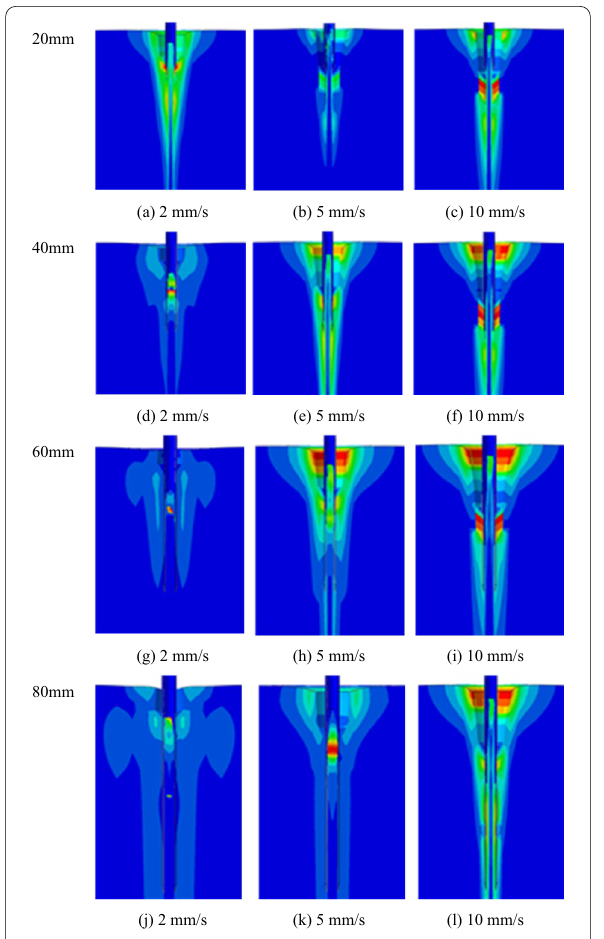
Figure 13 Stress changes at different puncture speed at 20 mm, 40 mm, 60 mm, 80 mm